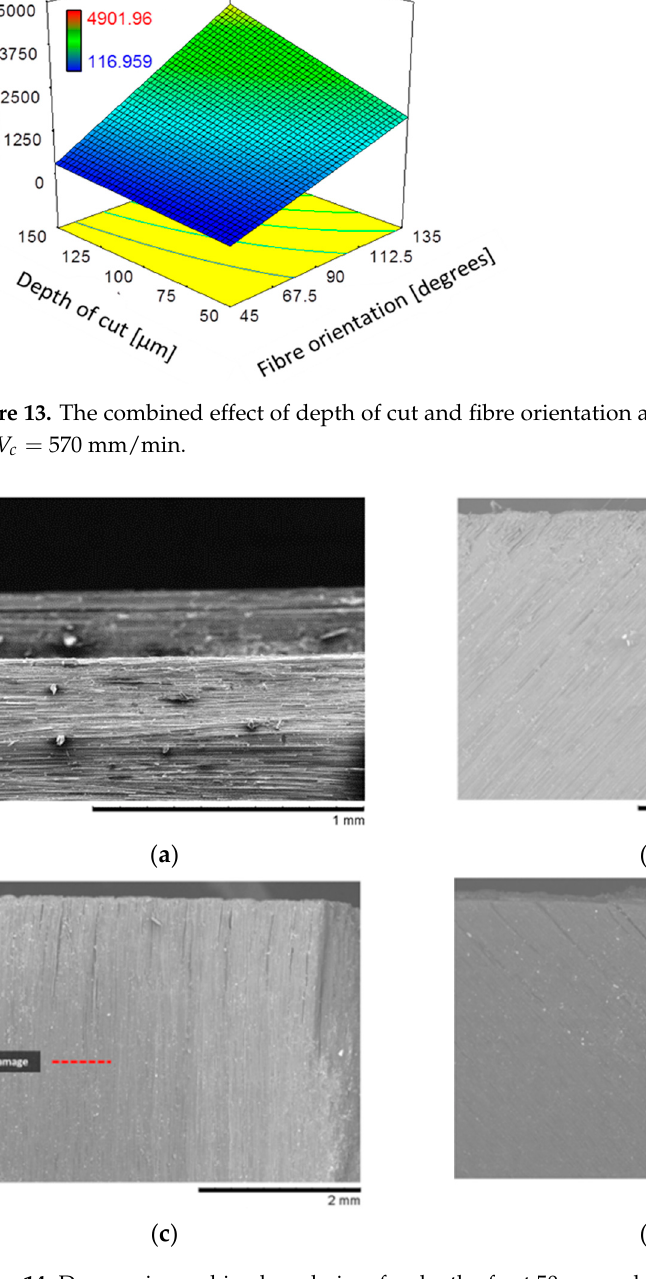
( b ) θ = 45°, ( c ) θ = 90°, and ( d ) θ = 135°, which correspond to experiments 5,14, 23, and 32 in Table 3, θ = 45 ◦ , ( c ) θ = 90 ◦ , and ( d ) θ = 135 ◦ , which correspond to experiments 5, 14, 23, and 32 in Table 3, respectively.